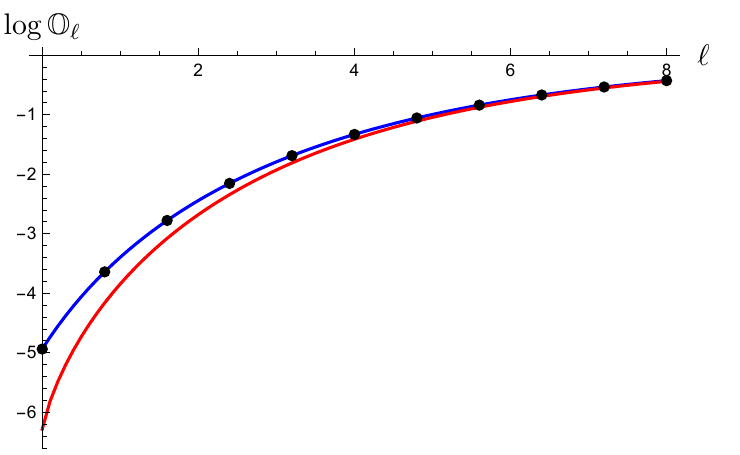
Figure 2 . The dependence of the octagon O ‘ =1 ( ξ = 0 . Black dots denote numerical values, red and blue curves describe weak and strong coupling expansions, respectively.